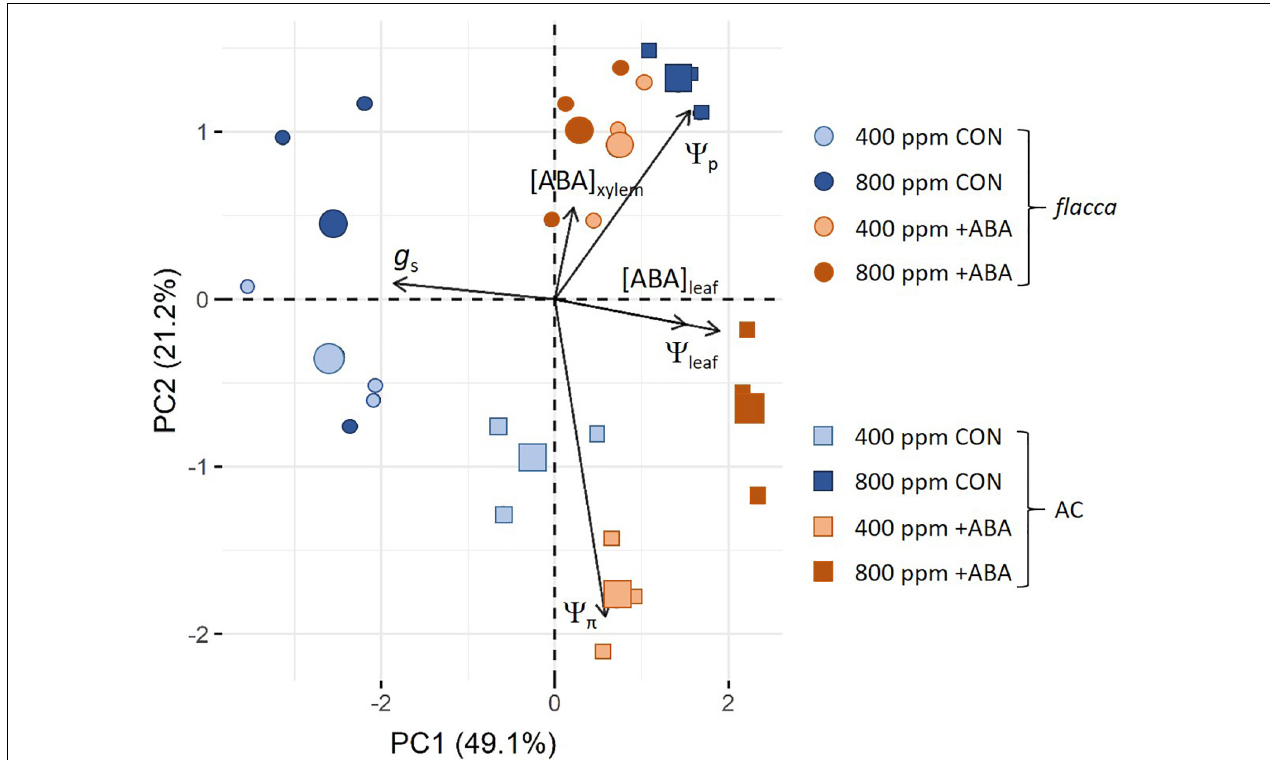
FIGURE 7 | Principal component analysis of stomatal conductance ( g s ), plant water relations, including leaf water potential ( (cid:57) leaf ), osmotic potential ( (cid:57) π ), and turgor pressure ( (cid:57) p ), and leaf and xylem sap ABA concentrations ([ABA] leaf , [ABA] xylem ) in well-water AC and flacca grown under ambient (400 ppm) and elevated (800 ppm) CO 2 at the time of the first harvest. CON indicates the control treatment sprayed with water, +ABA indicates exogenous ABA application. The contributions of each PCA axis (PC1 and PC2) are indicated on the